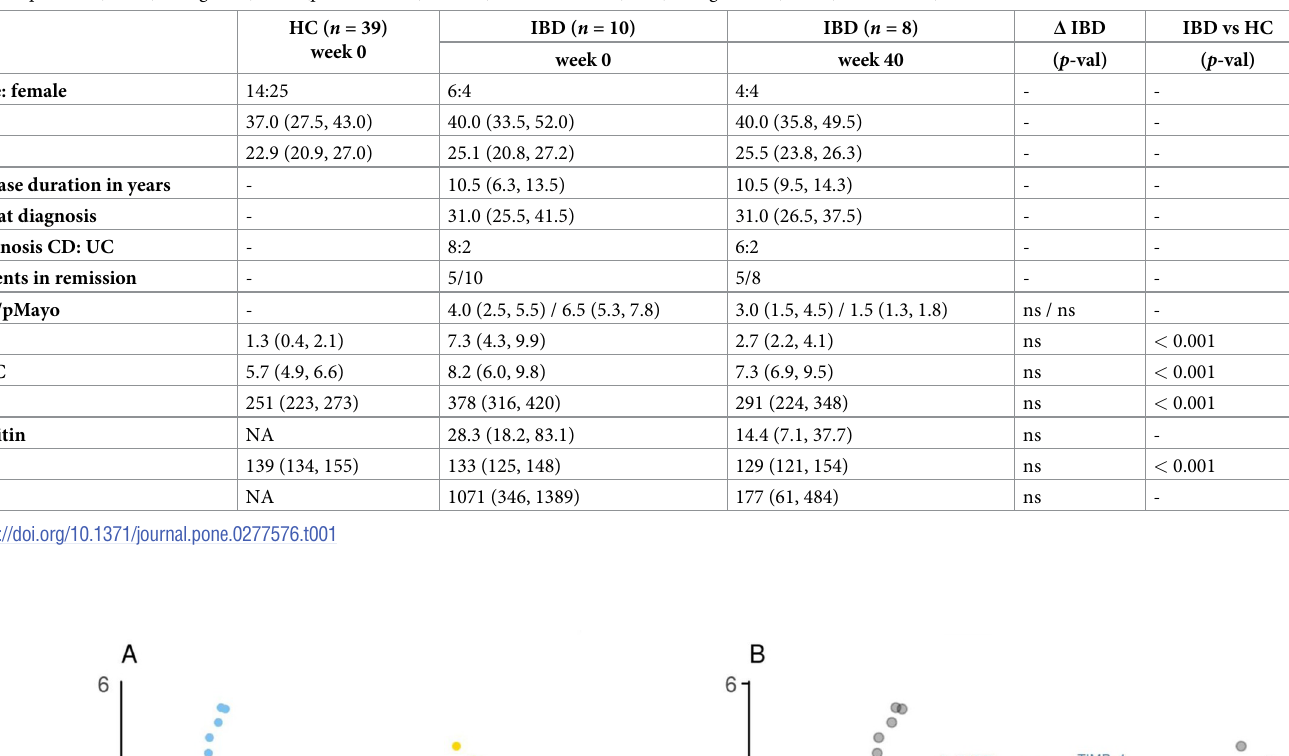
Table 1. Summary of anthropometric and clinical parameters from patients with IBD and healthy controls at the study baseline (week 0) and endpoint (week 40). In total, we collected samples from 11 patients with IBD (10 samples at baseline, 8 samples at endpoint) and 39 healthy controls. Comparisons between patients with IBD and HCs were evaluated by the Mann-Whitney U test. Changes during ustekinumab treatment (week 0 vs. week 40) were evaluated by Wilcoxon matched-pairs signed rank test. Bonferroni method was used to correct for multiple hypothesis testing. Medians are reported with the first and third quartiles in parentheses. n (number of par- ticipants), CD (Crohn’s disease), UC (ulcerative colitis), HC (healthy control), HBI (Harvey-Bradshaw Index), pMayo (partial Mayo score), CRP (C-reactive protein), FC (fecal calprotectin), Hb (hemoglobin), PLT (platelet count), WBC (white blood cells), ns (not significant), NA (not available).